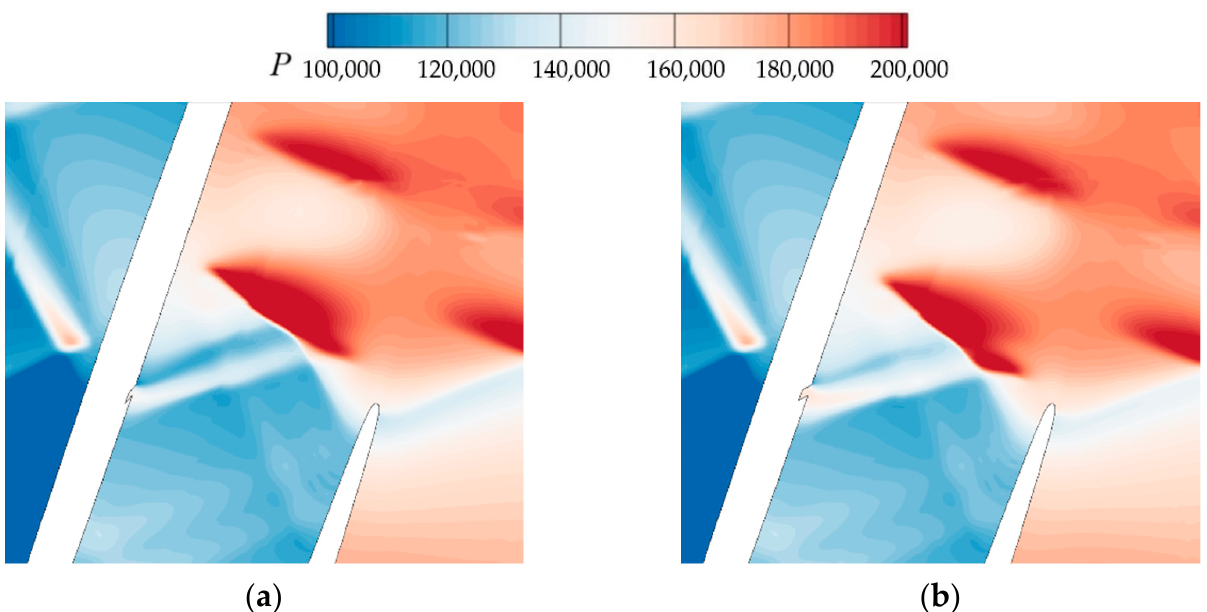
Figure 15. Static pressure contours with different angles of jet: ( a ) 𝛼 = 20° ; ( b ) 𝛼 = 40° .